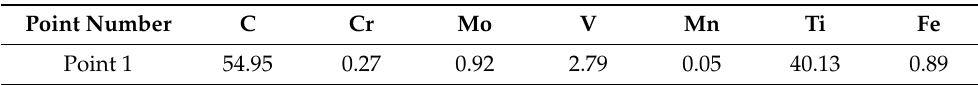
Figure 8. Distribution of alloying elements in TiC particle: ( a ) Point composition analysis, ( b ) Linear scanning results. Table 4. EPMA results of point 1 (at.%).